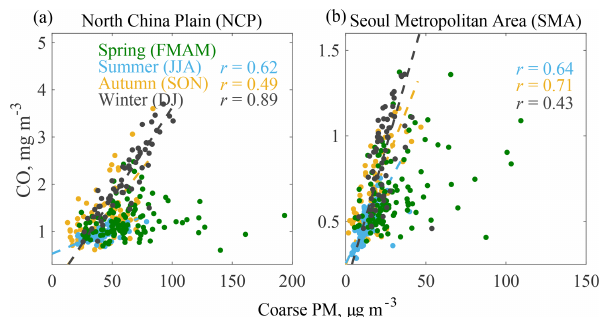
Figure 3. Daily correlations of coarse PM and CO concentra- tions over the North China Plain (NCP) and Seoul Metropolitan Area (SMA) in 2015. Coarse PM and CO concentrations are 24h averages of air quality network observations spatially averaged over the two regions. Also shown are the correlation coefficients and reduced-major-axis regression lines, except in spring when the cor- relation is not significant ( p value > 0.05). We include February in spring to cover the season of natural dust events (Tang and Han,